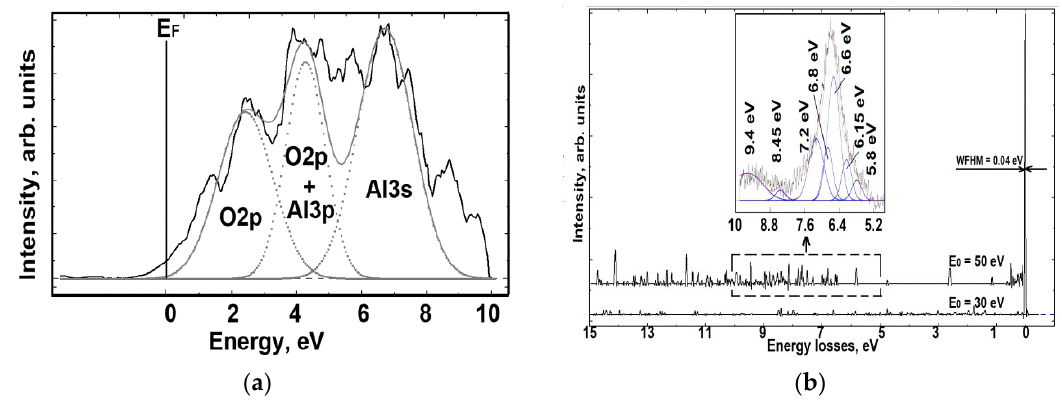
Figure 3. Fine structure of 170 nm Al 2 O 3 layer valence band obtained by XPS ( a ) and interband transitions spectra, excited by primary electron beams with energies of 30 and 50 eV ( b ). The full width at half maximum (FWHM) of the back scattered electron peak is 40 μeV. The dotted lines are displaying fitted components of valence electrons and interband transitions.